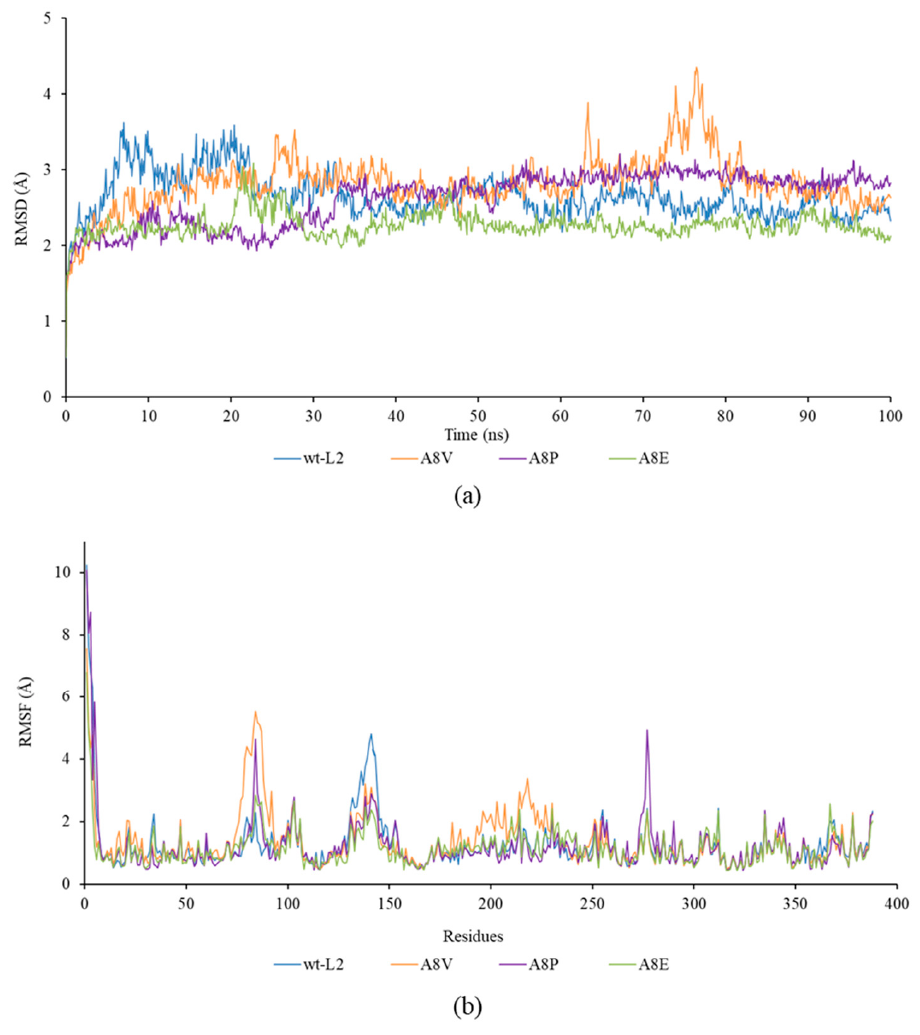
Figure 3. Molecular Dynamics (MD) simulation analysis of wt-L2 and mutant lipases for 100 ns using YASARA. ( a ) The root mean square deviation (RMSD) values. ( b ) The root mean square fluctuation (RMSF).